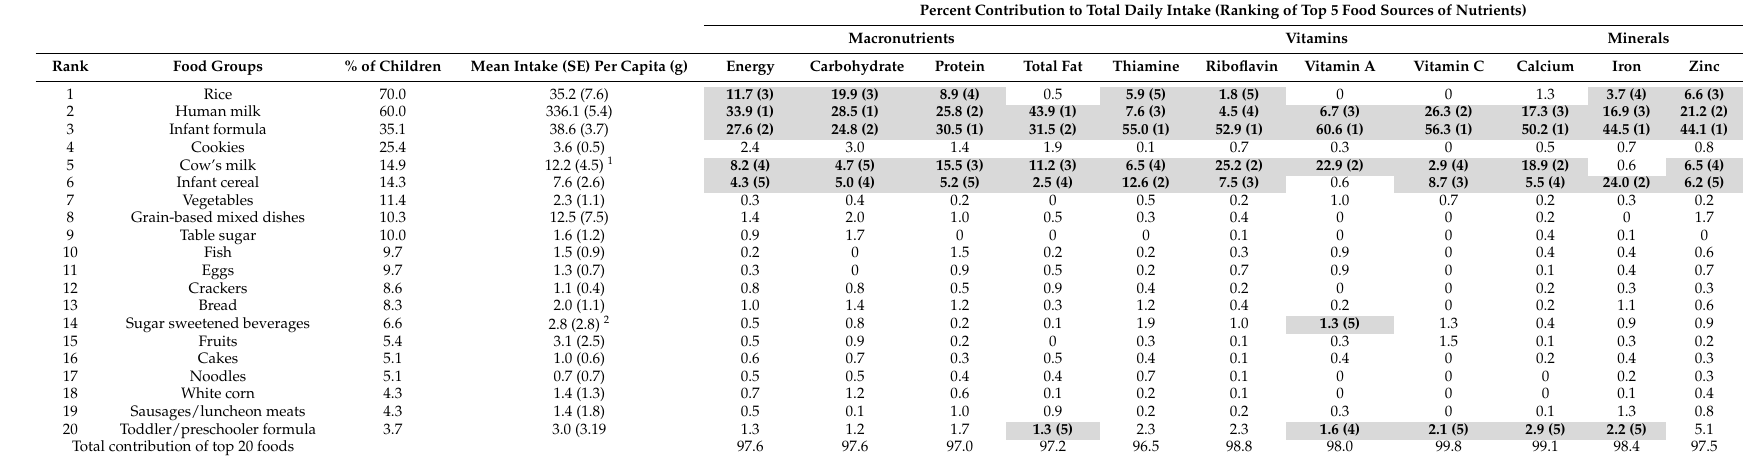
Table 4. Top-20 most consumed food groups and their contribution to energy and selected nutrient intakes among infants aged 6–11 months ( n = 350) in the